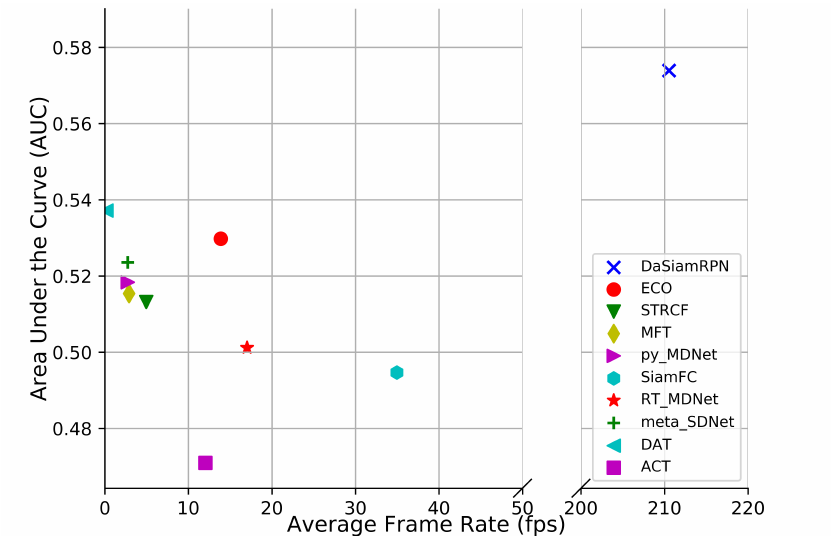
Figure 10. Results showing AUC vs. Frame Rate on UAV123 dataset. Top right corner indicates fastest implementation and best performance. Best viewed in